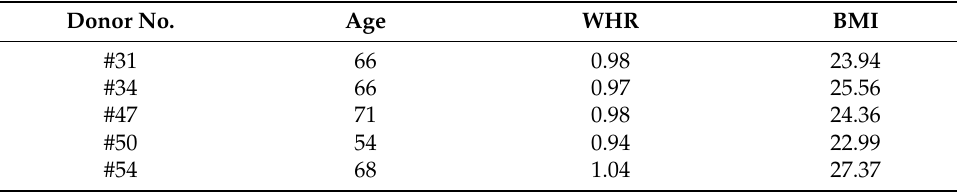
Table 1. Clinical information regarding the donors of